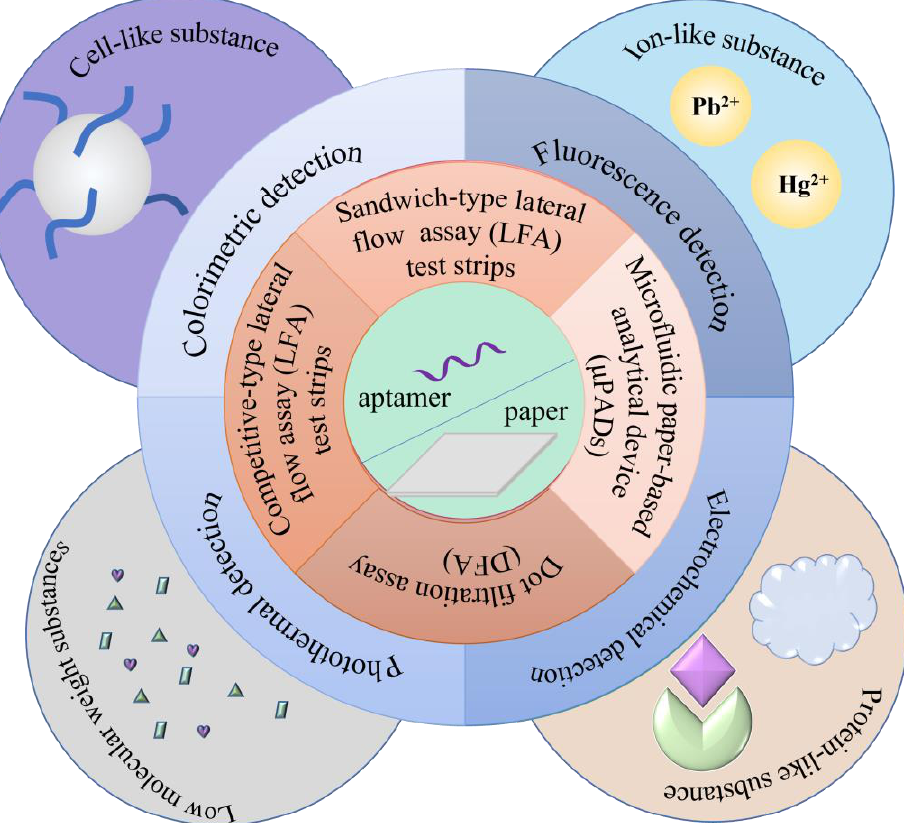
Figure 7. Overview of the use of aptamer in paper-based sensors.